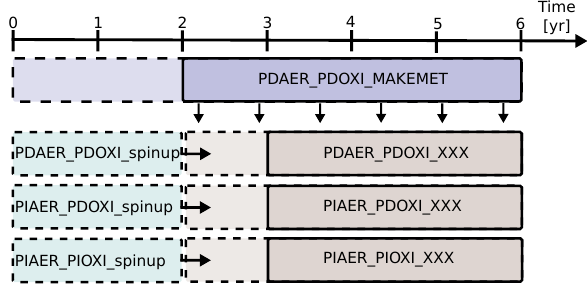
Figure 2. Overview of how the simulations were carried out. PDAER_PDOXI_MAKEMET produced meteorology for the other simulations from its last 4 years. Dashed lines show the part of the simulations used as spin-up. Horizontal arrows show that the simulations to the right of the arrow restarted from the already spun up simulation to the left. The spin-up cases were not nudged, but started with free-running meteorology from the same state as PDAER_PDOXI_MAKEMET. XXX refers to either ORG (origi- nal model setup), or the name of the sensitivity tests described in Sects. 3.2 and